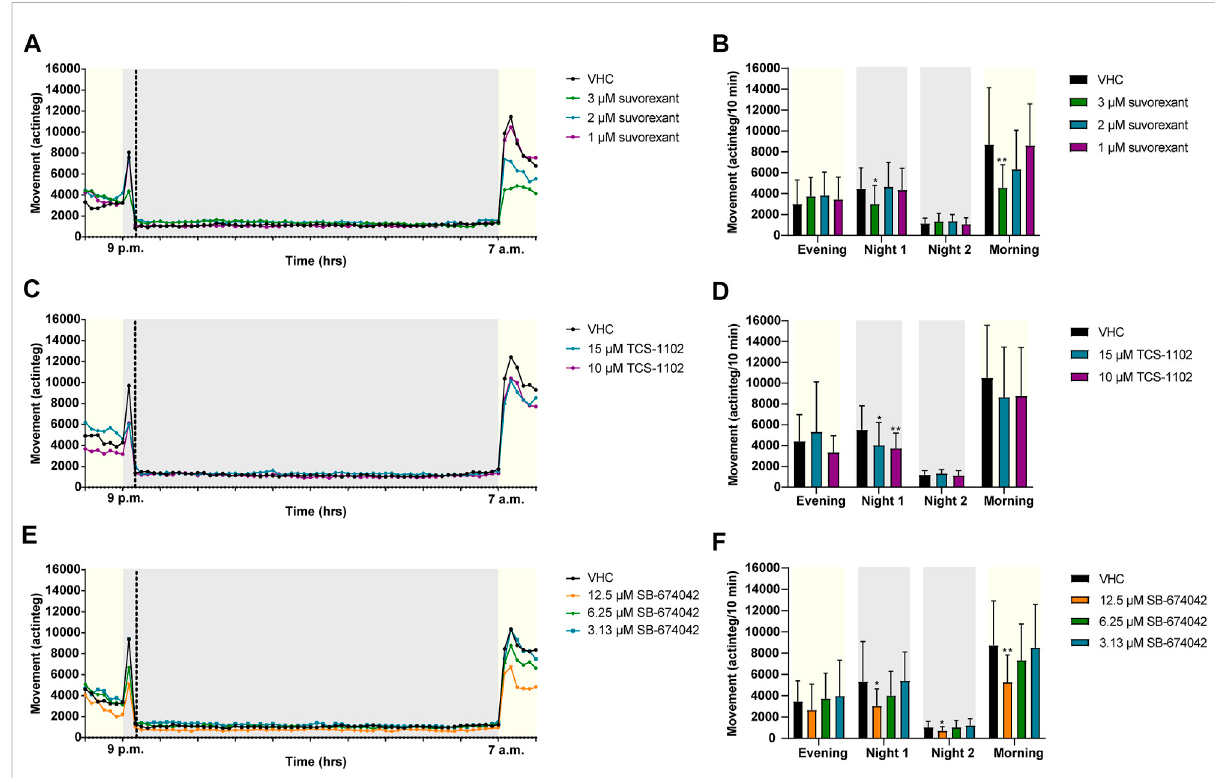
FIGURE 4 Behavioral analysis of 6 dpf zebra fi sh larvae treated with orexin receptor antagonists in the night assay. Locomotor pro fi les of animals are expressed as mean actinteg units per 10 min treated with suvorexant (A) , TCS-1102 (C) and SB-674042 (E) are plotted as function of time. Different phases are shown, i.e. the light phase from 8 p.m. to 9 p.m. (i.e., Evening), the fi rst dark phase from 9 p.m. to 9:20 p.m. (i.e., Dark 1), the second dark phasefrom9:20p.m.to7a.m.(i.e.,Dark2),andthelightphasefrom7a.m.to8a.m.(i.e.,Morning).Forthesakeofclarity,standarddeviationsare not shown. Total locomotor activity was averaged (±SD) per respective light or dark phase (B – F) For each compound, data were pooled from three independent experiments with 9 – 10 replicate wells per test condition ( n = 27 – 30, except for 15 µM TCS-1102 ( n = 20)). Statistical analysis: